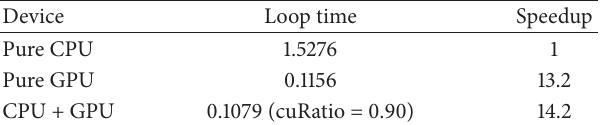
Table 5: Speedup ratio (64NP, problem size 2048 × 1024 ×